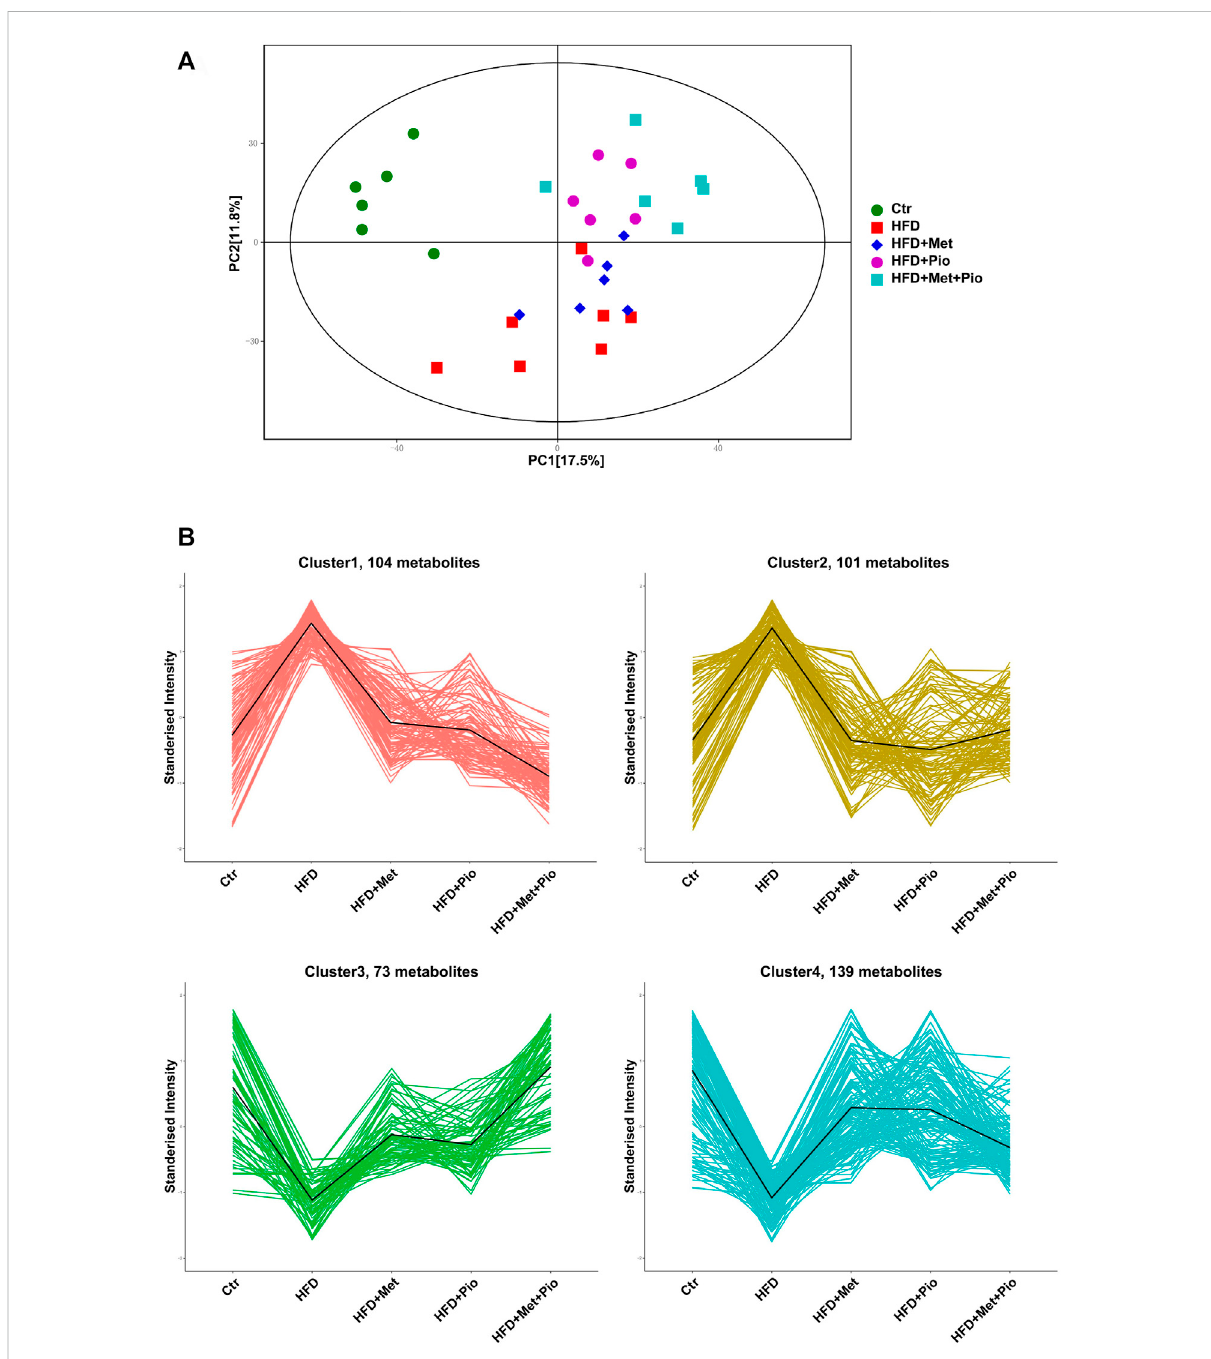
FIGURE 4 Cluster analysis of the gut metabolites. (A) PCA score plot; (B) Four clusters of the gut metabolites altered with combination therapy of metformin and pioglitazone by manual classi fi cation. Ctr, standard control diet; HFD, high-fat diet; HFD+Met, high-fat diet treated with metformin; HFD+Pio, high-fat diet treated with pioglitazone; HFD+Met+Pio, high-fat diet treated with metformin and